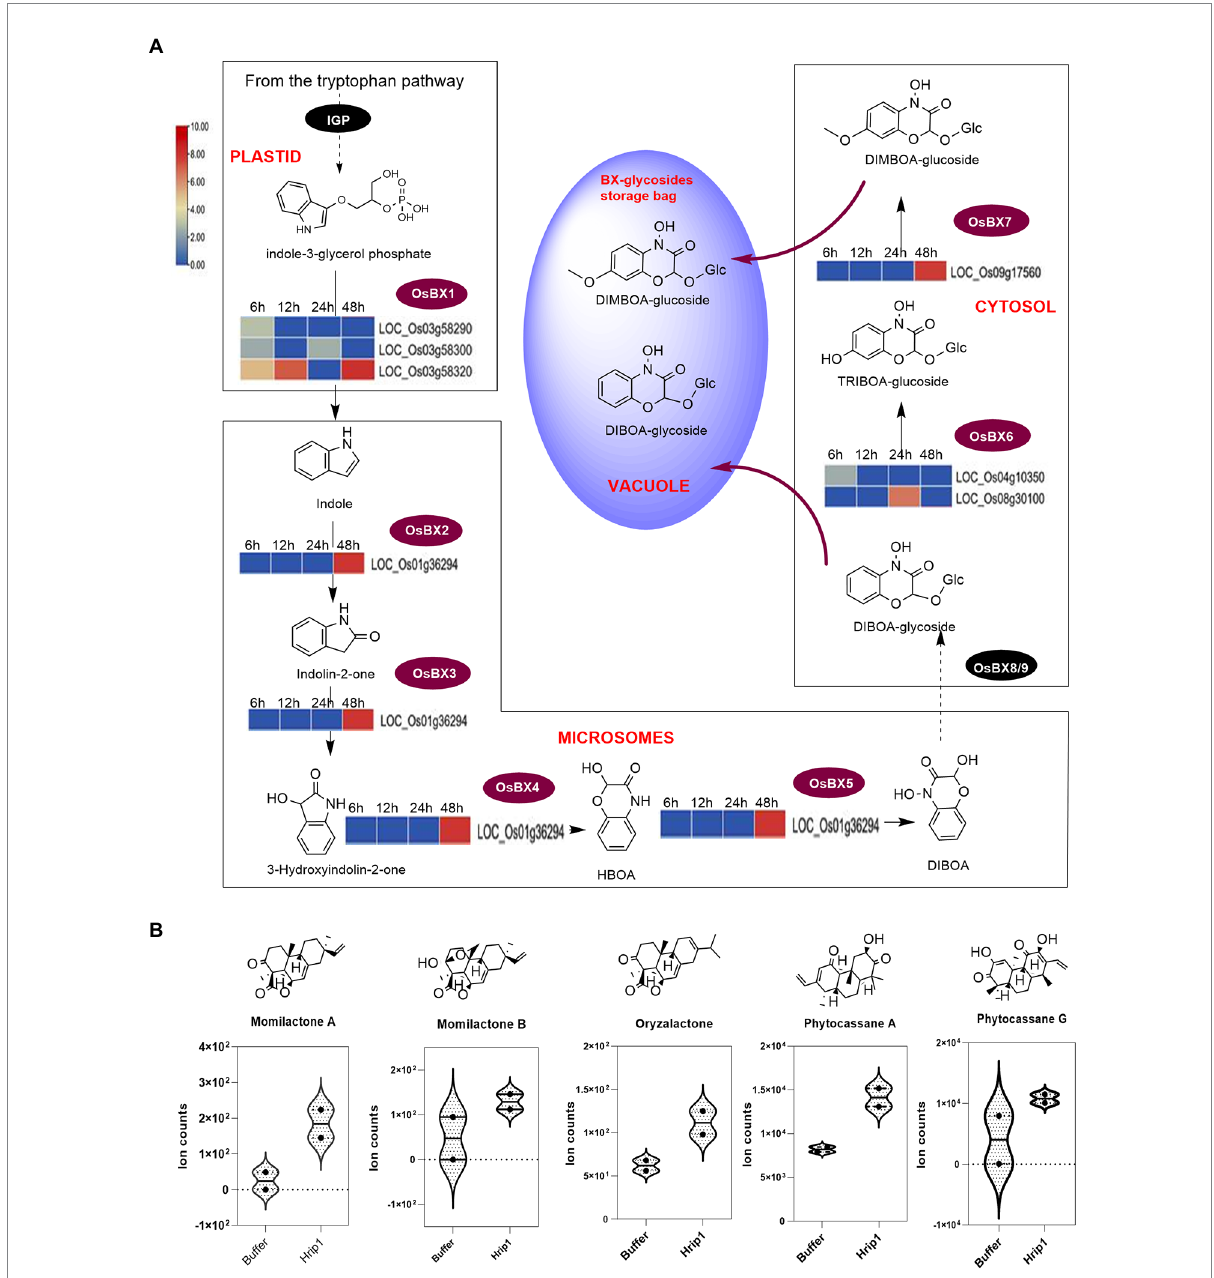
FIGURE 5 DEGs encoding BX biosynthesis and phytoalexin diterpene contents in rice seedlings. (A) BX biosynthesis pathway showing the steps each gene encodes. Reaction steps are classified according to their sites of occurrence (organelles). BX-glycosides are finally deposited in the vacuole and elicited upon biotic stress perception. (B) UPLC-MS/MS analysis of diterpenoids ( n =